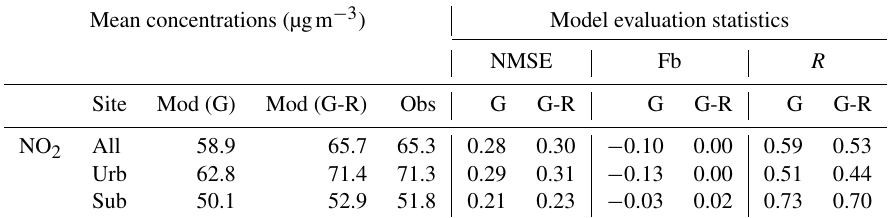
Figure 15. Hourly PM 2 . 5 concentrations at measurement sites 1, 2, 3, 10 and 14 during the campaign period. Wind vectors, representing wind speed magnitude and direction recorded at the airport meteorological station, are also provided (black arrows). Table 5. Same information presented as in Table 4 but for NO 2 concentrations simulated (MEIC Opt) using 3-D grid sources only (G) as well as 3-D grid and explicit road sources (G-R) (also presented in Table 4). Mean concentrations (µgm − 3